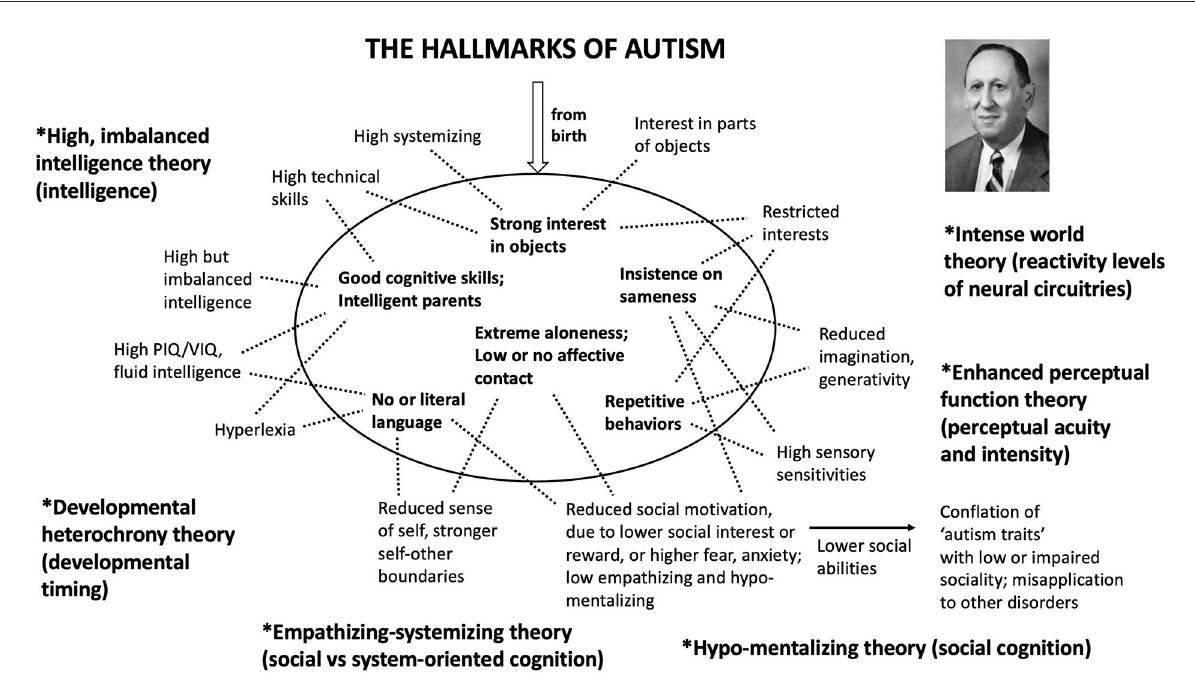
FIGURE1 The six main “hallmarks of autism” described by Kanner in his 1943 paper. These hallmarks represent the core phenotypes that Kanner used to define and describe the syndrome of autism. Each of them has since been connected (here, by the dotted lines) with additional traits that are associated with autism. They are also linked with the main theories set forth for understanding autism (here, in boldface); these theories include systemizing and empathizing (34), enhanced perceptual function and veridical mapping (35, 36), neuronal hyper-excitability and plasticity (37), and high but imbalanced intelligence, hyperdeveloped patternistic cognition, developmental heterochrony, and hypo-developed mentalizing (38–40). Each theory is followed in parentheses by the adaptation(s) that, by the theory, are altered in autism. These theories show evidence of strong connections with one another, especially as regards intelligence with high perceptual function and neural reactivity, and low empathizing with hypo-mentalism; relatively or absolutely enhanced non-social cognitive abilities and interests are also prominent in all of